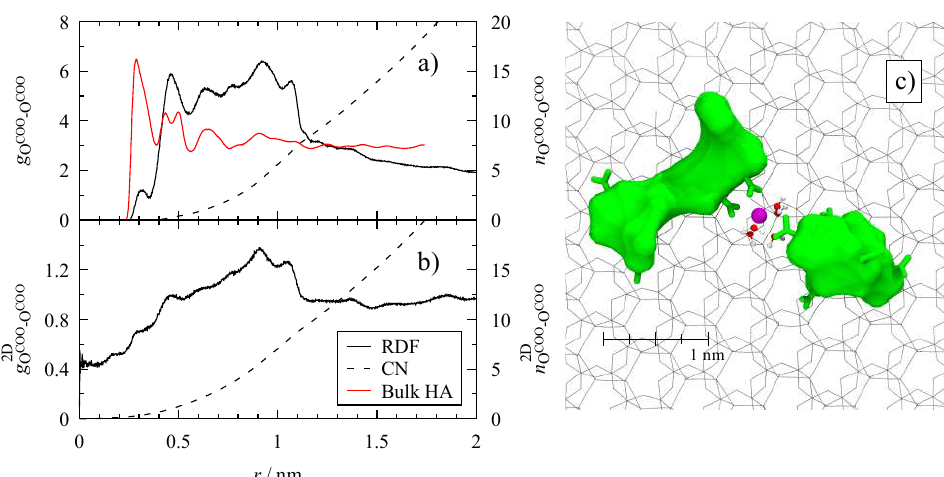
Figure 6. Conventional ( a ) and lateral ( b ) radial distribution functions (RDFs; g ij ) and running coordination numbers (CN) of carboxylate oxygen atoms of HAs on the aluminol side at distance r from the reference atom confined in HA– z (0 < z < 1.15 nm). The black and red lines correspond to the RDFs in this work and in a bulk HA matrix from Galicia–Andrés et al. [20], respectively. The red line is scaled three times for better visualization. Top view ( xy –plane) of HAs patches (green isosurfaces) adsorbed on the aluminol surface of kaolinite (gray lines) and forming a cation bridge through the Ca 2+ cation (magenta ball) ( c ).